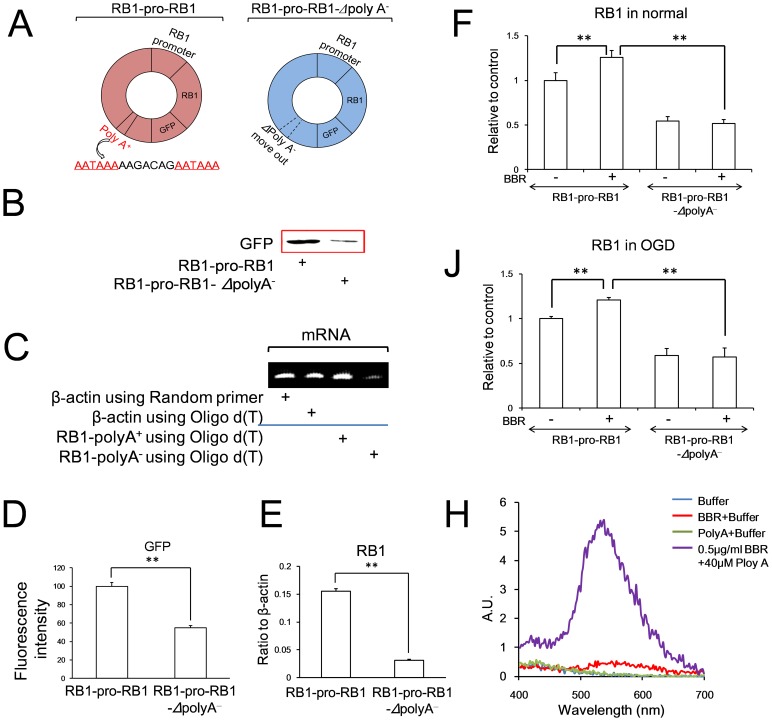
Effects of berberine (BBR) to inhibit the degradation of RB1 mRNA with poly(A) (RB1-pro-RB1) or without poly(A) (RB1-pro-RB1-Δpoly A-).(A) Cartoon of the plasmid models used in this study. Polyadenylation signals were showed in red. (B) Expressions of GFP in cells with transfection of RB1-promoter-RB1-GFP with and without poly(A) plasmids detected using Western blot. (C) Expressions of β-actin and RB1 mRNA using random primer and oligo d(T) in the cells with transfection of RB1-promoter-RB1-GFP with and without poly(A) plasmids detected using RT PCR. (D) Fluorescence intensity in cells with transfection of RB1-promoter-RB1-GFP with and without poly(A) plasmids detected using flow cytometry. (E) RB1 mRNA expressions using oligo d(T) as the primer in cells with transfection of RB1-promoter-RB1-GFP with and without poly(A) plasmids detected using real time PCR. (F) RB1 mRNA level in PC12 cells in normal conditions with transfection of RB1-promoter-RB1-GFP with and without poly(A) plasmids administrated with or without BBR. (J) RB1 mRNA level in PC12 cells in oxygen and glucose deprivation (OGD) conditions with transfection of RB1-promoter-RB1-GFP with and without poly(A) plasmids administrated with or without BBR. (H) The fluorescence spectrum of BBR associating with poly(A) (40 µM). BBR was 0.5 µg/ml. Data are presented as mean ± S.D. from three independent experiments (n = 3). **P<0.01.